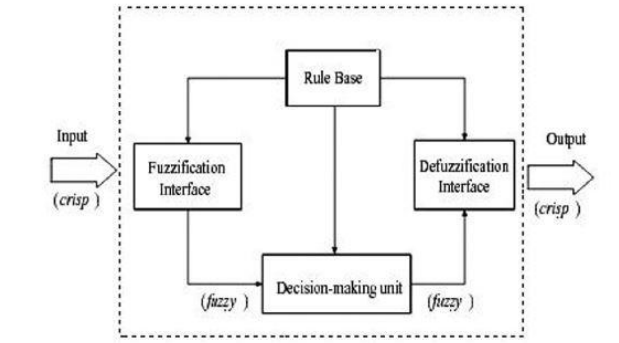
Figure 5. Fuzzy logic